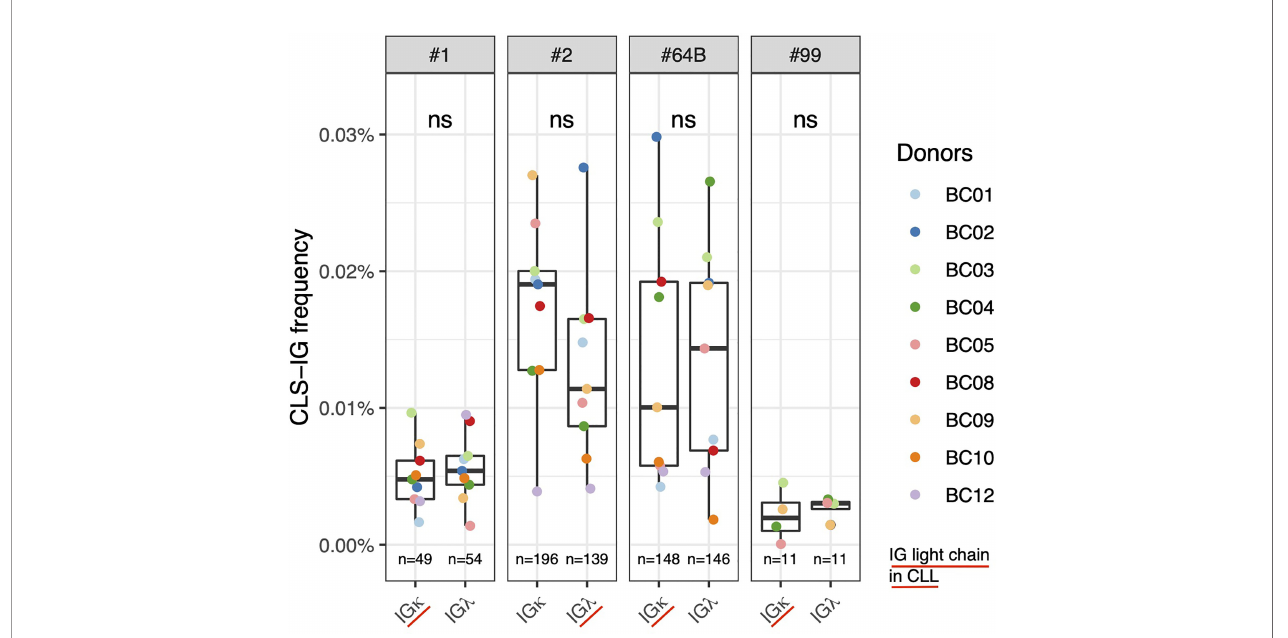
FIGURE 5 | Frequency of individual CLS-IG in sequences from normal B cells expressing either IG k and IG l chains in CLL stereotyped subsets with reported IG light chainIGL bias (6, 12). Paired Wilcoxon test was performed. ns, not signi fi